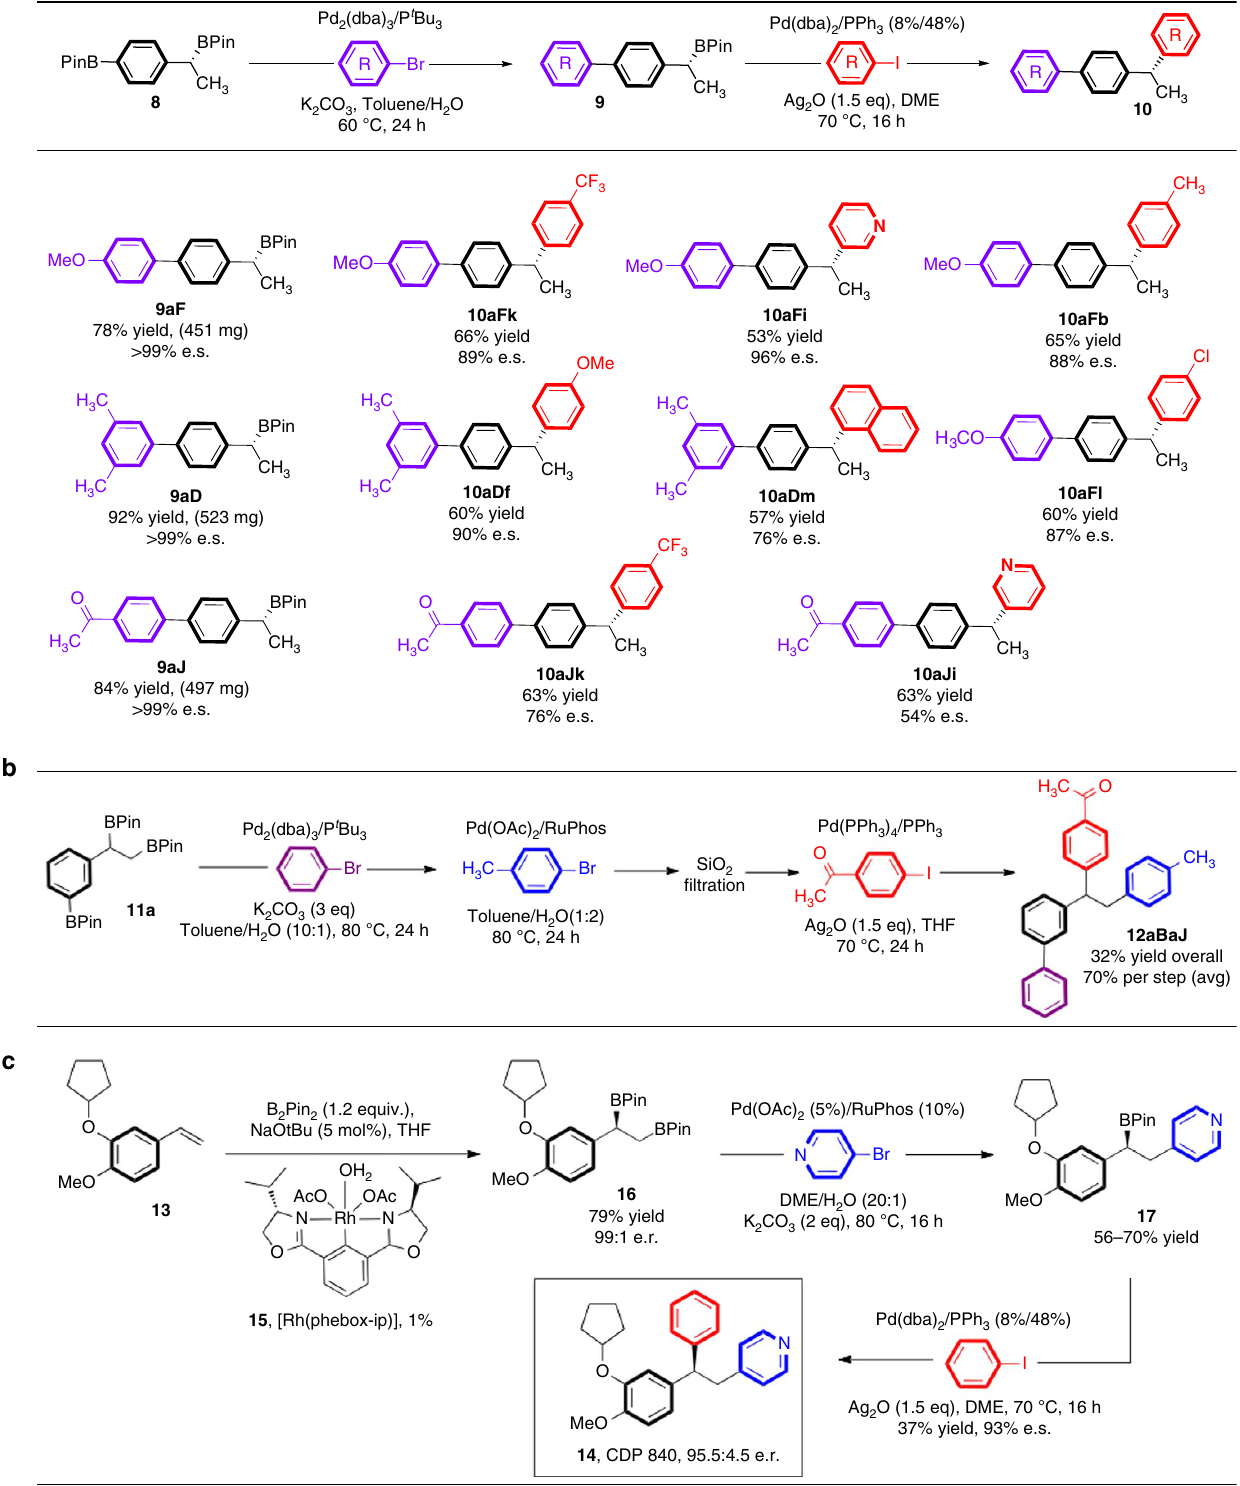
Figure 4 | Chemoselective cross-couplings of bis- and tris-borylated chiral aromatics. ( a ) Initial selective coupling of aryl B–C bonds using Pd/P t Bu 3 as the catalyst and carbonate bases, followed by second, stereospecific coupling of chiral secondary benzylic B–C bond leading to biphenyl-substituted 1,1–diaryl alkanes. ( b ) The introduction of three unique aryl groups sequentially by coupling at (1) the aryl B–C bond, (2) the linear achiral